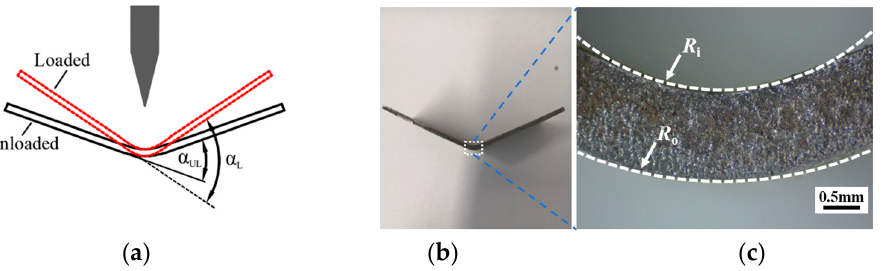
Figure 3. ( a ) Schematics of the cross-sections in the loaded and unloaded specimens; ( b ) cross-section of an unloaded specimen after being cut along the center line in the width direction; ( c ) enlarged view of the deformed zone (highlighted by the dashed line in Figure 1b) in an unloaded specimen.